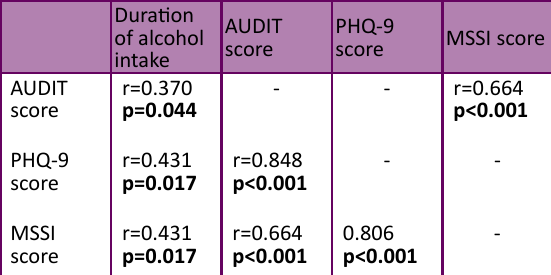
Table 1. Correlation between severity of alcohol use and outcomes Duration AUDIT of alcohol intake